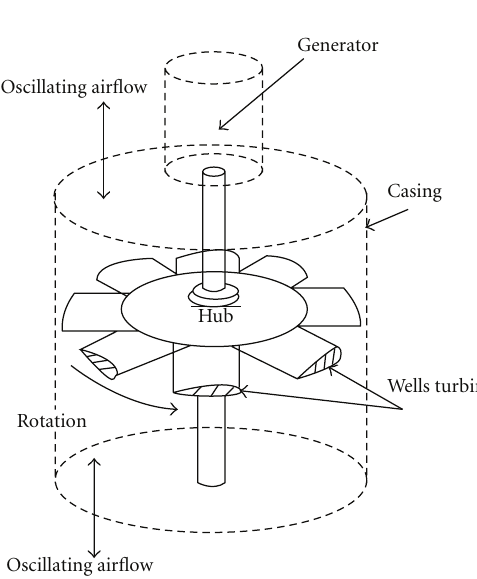
Figure 2: Outline of Wells turbine.